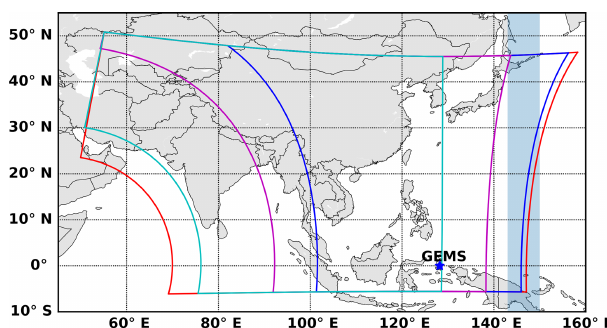
Figure 1. GEMS field of regard (red), nominal daily scan (blue), full central scan (magenta), full western scan (cyan), and GEMS loca- tion (blue star). Shaded areas (143–150 ◦ E) are regions for radiance references and common